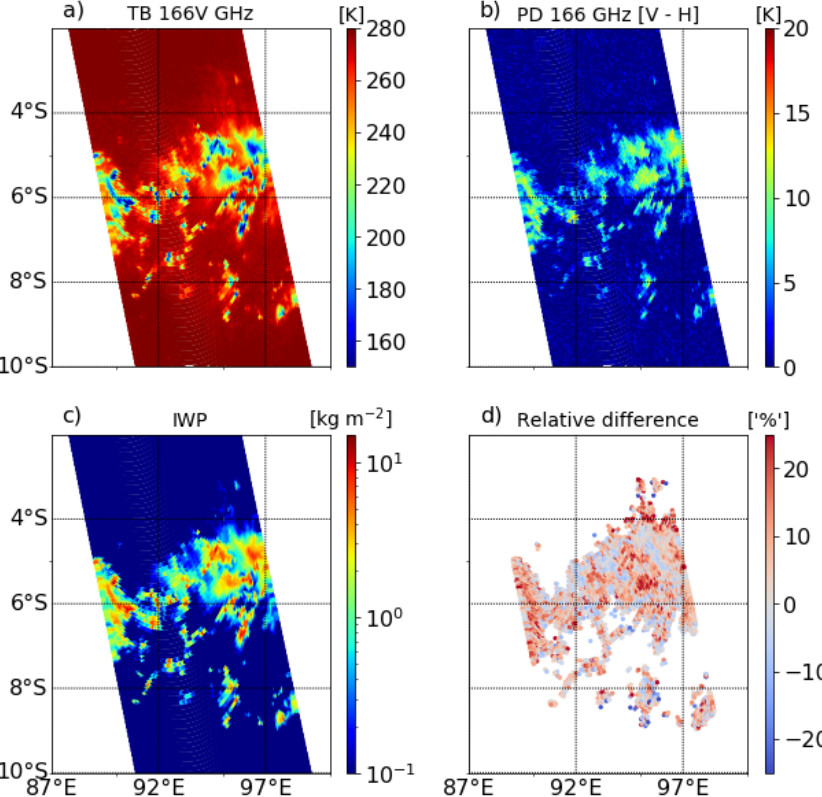
Figure 13. ( a – d ) An example convection system observed by GMI on 15 January 2017. The top two panels show the observed TBs at 166VGHz and the PD between the dual-polarised channels (166V − 166H). The bottom left-hand panel shows the retrieved IWPs when oriented hydrometeors were considered, while the right-hand panel shows the relative differences from the IWP retrievals when the orientation was neglected. The relative differences for clear-sky regions (IWP < 0.01 kg m − 2 ) were